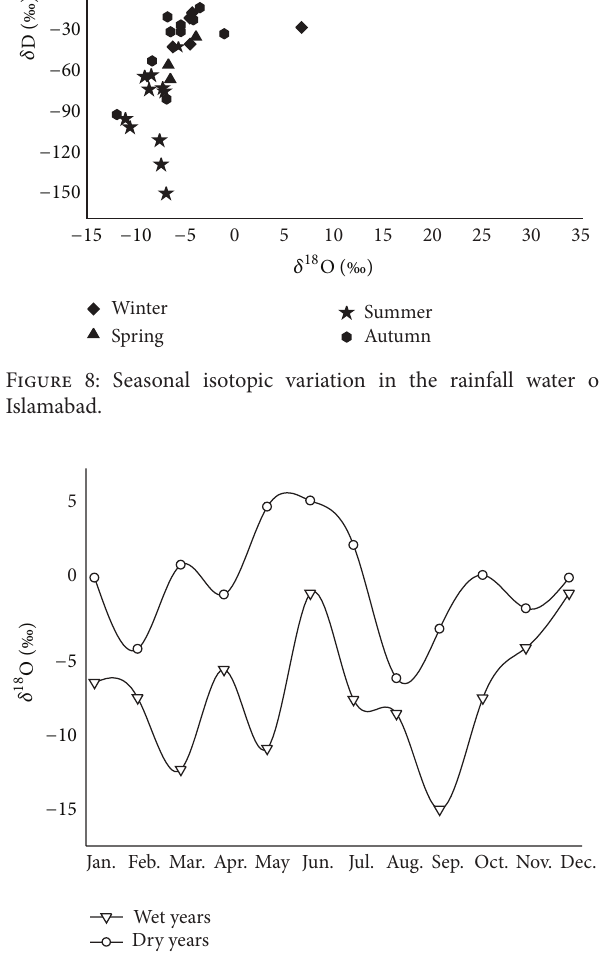
Figure 9: Monthly 𝛿 18 O in dry and wet years in rainfall water of